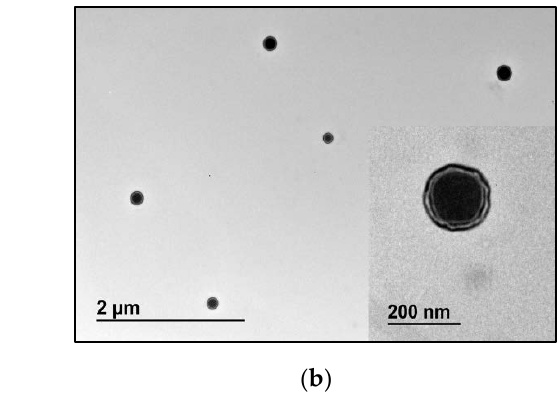
Figure 2. ( a ) SEM and ( b ) TEM images of the MK-2048-loaded PNPs. Scale bars are shown on each image. The TEM image consists of two scales with a close-up of one PNP inserted.